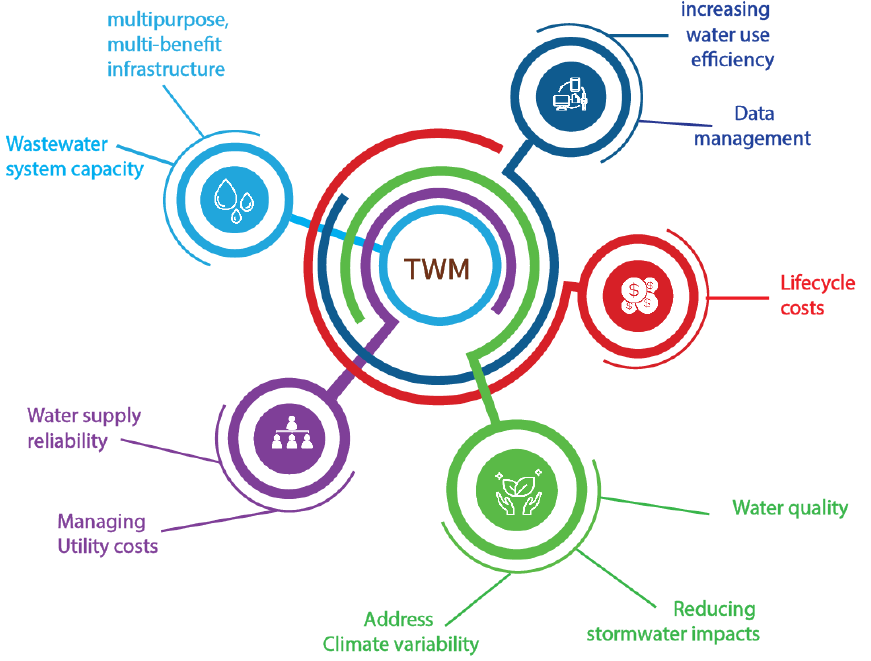
Figure 6. Total Water Management in the US.